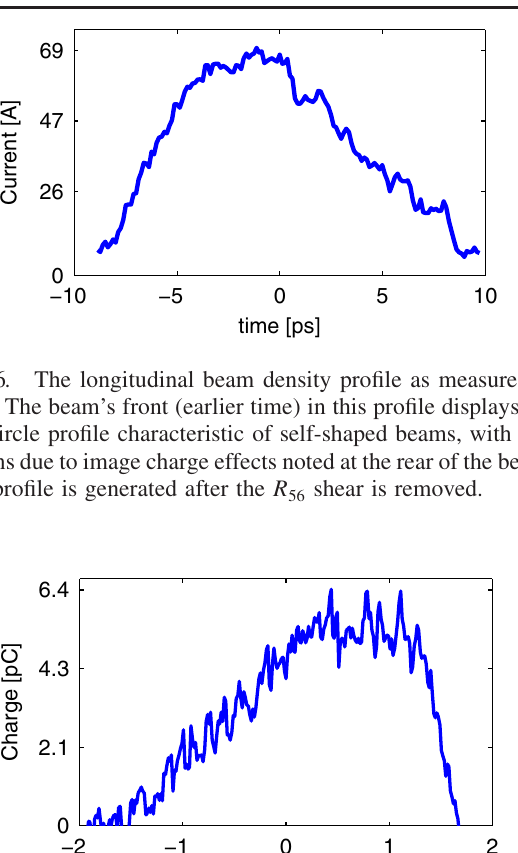
FIG. 5. The simulated PARMELA beam after passage through a dipole, using simple matrix transport methods. While the overall shape is similar to the beam as measured at PITZ, features such as a denser beam head are not reproduced, likely due to lack of inclusion of collective charge effects.